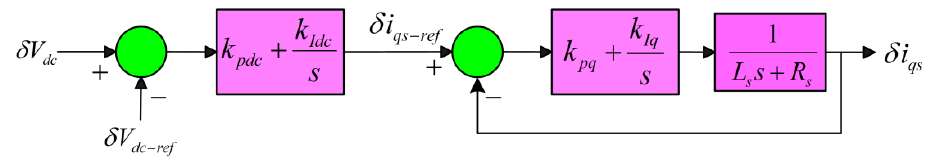
Figure 8. Small signal block diagram of dc-link voltage and q-axis current controller.